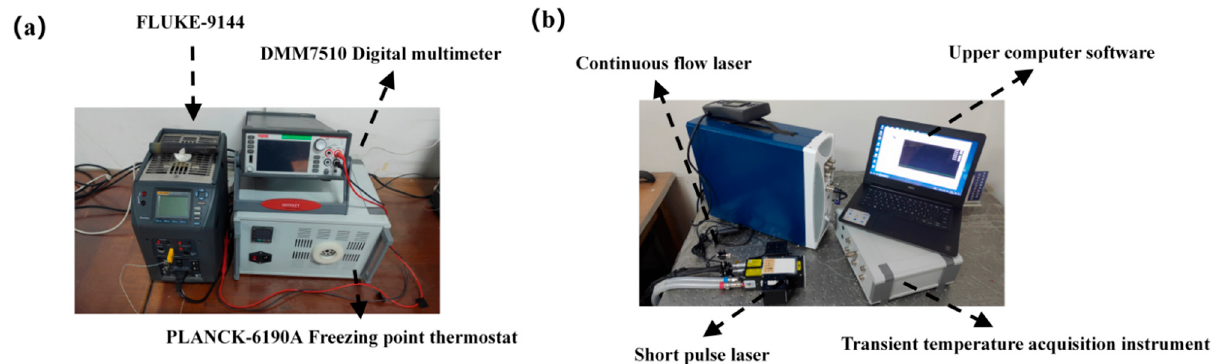
Figure 8. ( a ) Static calibration system. ( b ) Dynamic calibration system.